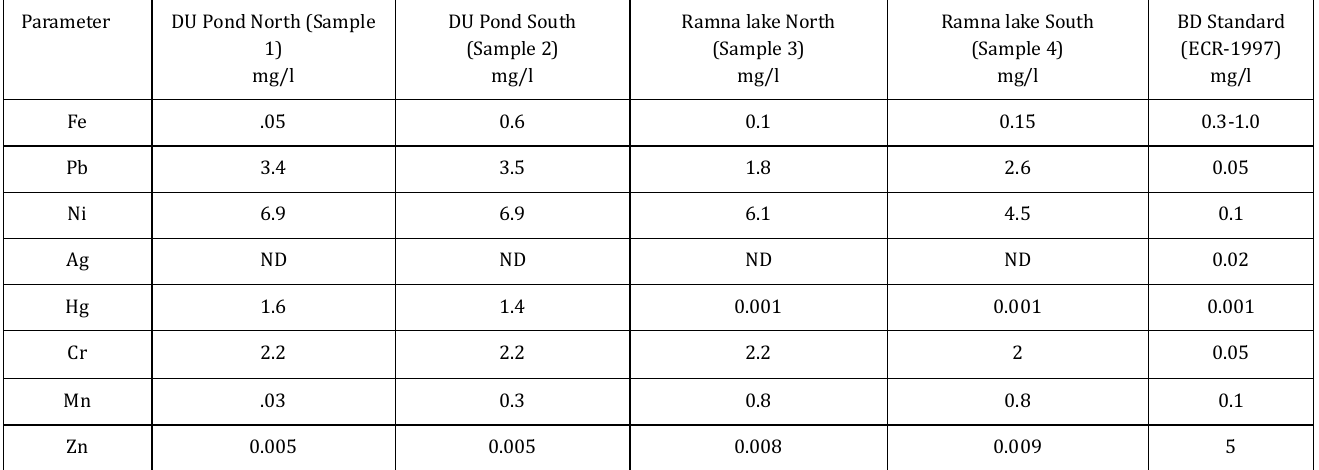
Table 3: Result of Heavy metals